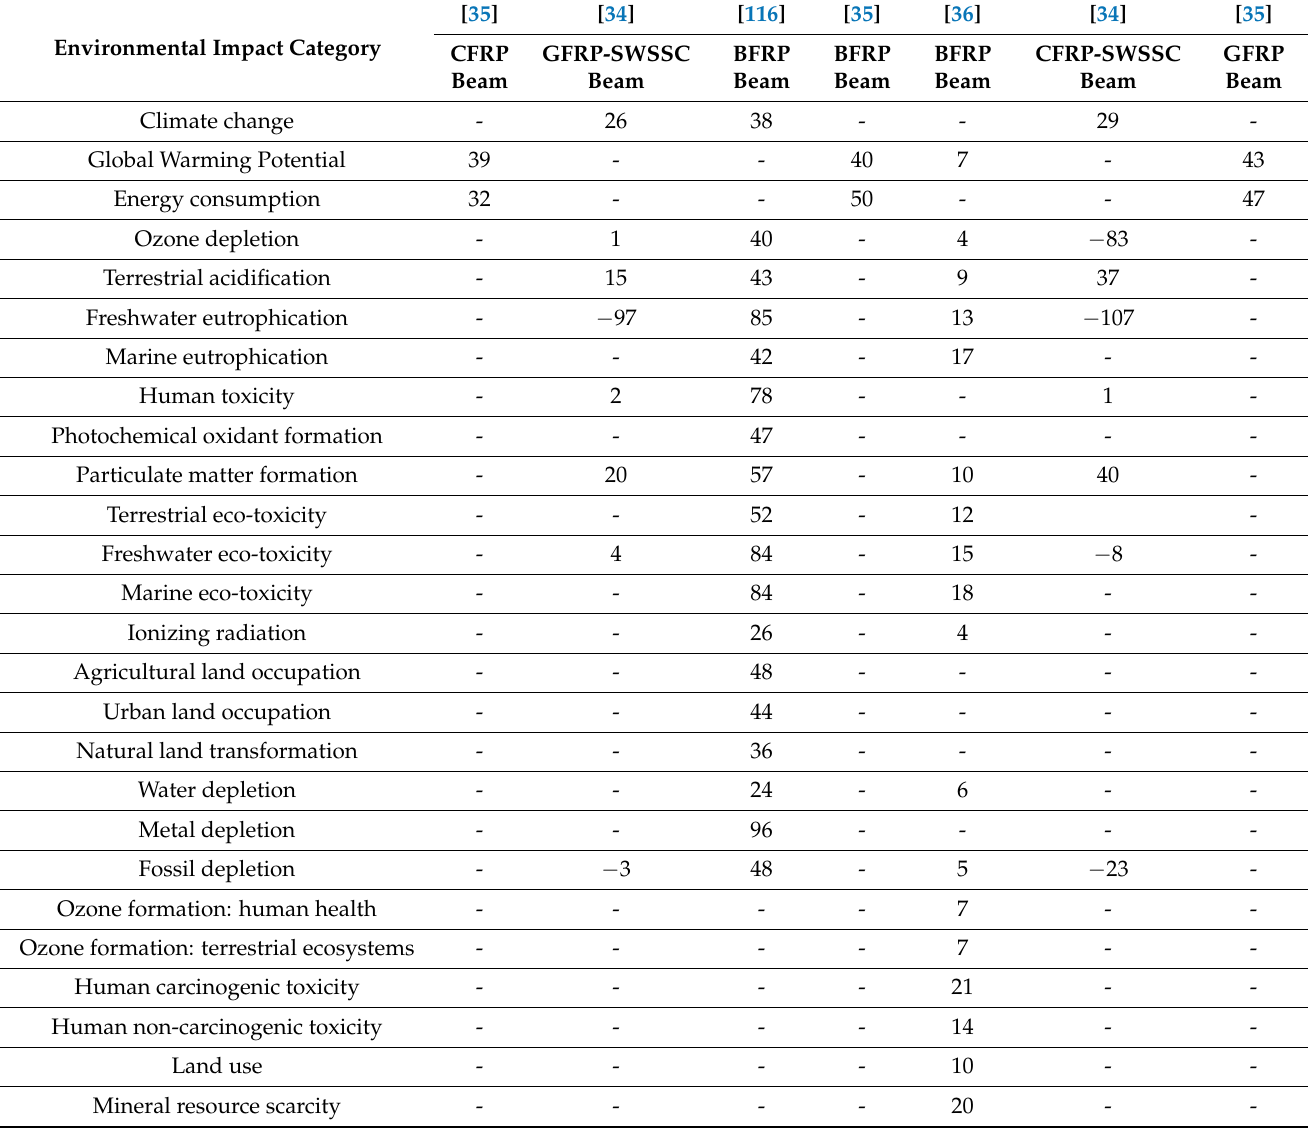
Table 8. LCA of different studies showing the improvement made by using FRP bars instead of steel bars as a percentage